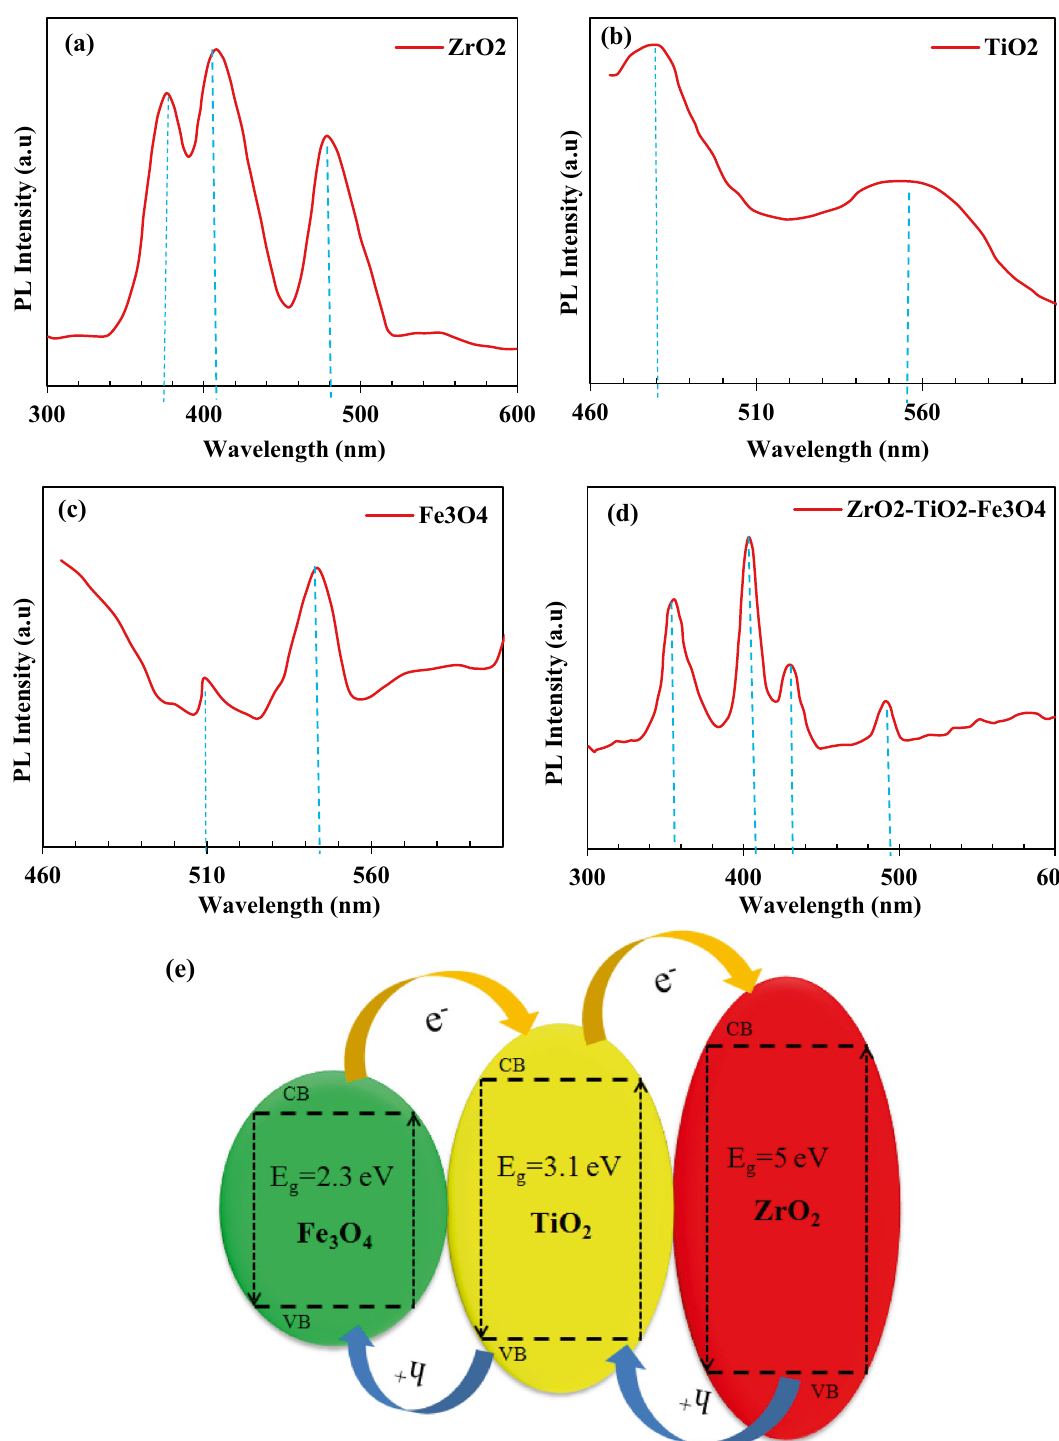
Figure 8. Photoluminescence (PL) spectra of ( a ) ZrO 2, ( b ) TiO 2, ( c ) Fe 3 O 4 nanoparticles and ( d ) ZrO 2 / TiO 2 /Fe 3 O 4 nanocomposite, ( e ) Energy level and electron–hole pair separation/transfer in ZrO 2 /TiO 2 /Fe 3 O 4